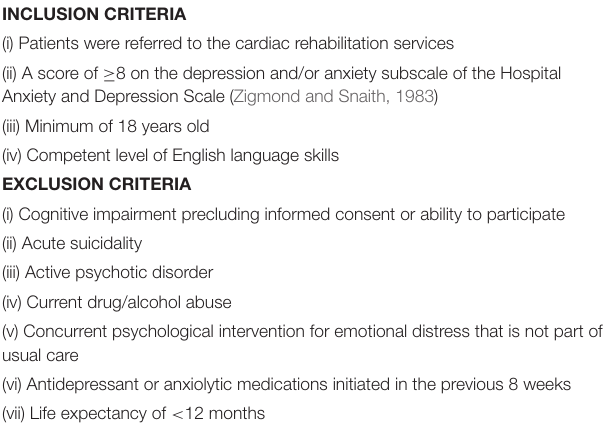
TABLE 1 | Participant’s eligibility: inclusion and exclusion